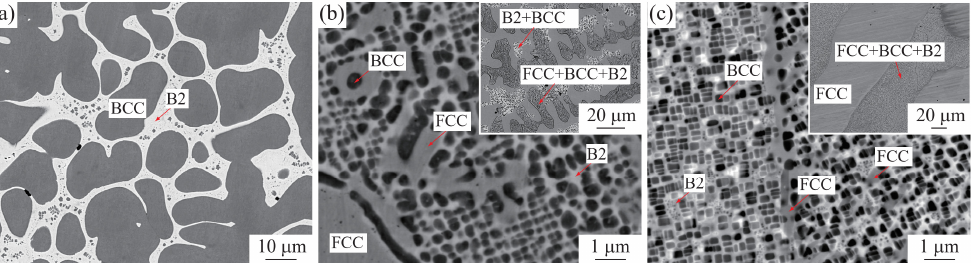
Figure 3. Microstructures of ( a ) the as-cast Ni16.54-Ga13.63-Cr69.83 alloy, ( b ) as-cast and ( c ) annealed Ni42.23-Ga15.70-Cr42.07 alloys (the insets are the images with low magnification). Annealing is performed at 1150 °C for 10 days for Ni42.23-Ga15.70-Cr42.07 (at. %) alloys.